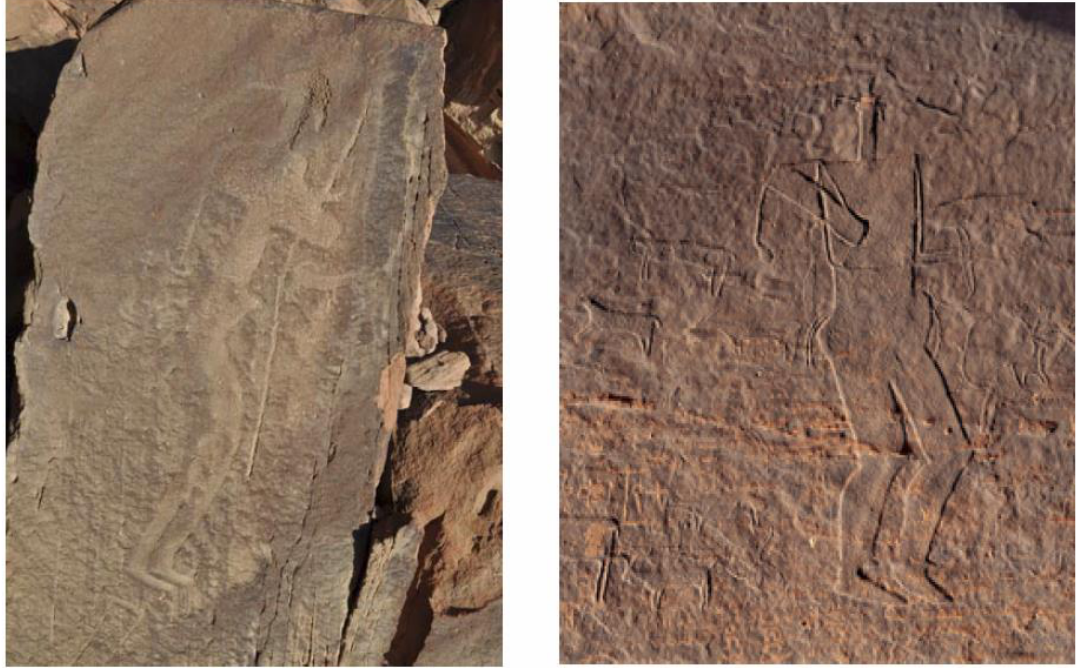
Figure 7. Strange, human-like figures in standing a profile form, located at Jubbah (left) and Shuwaymis (right), northern region. The ambiguous faces and long narrow necks are typical features of the Neolithic art in Arabia.